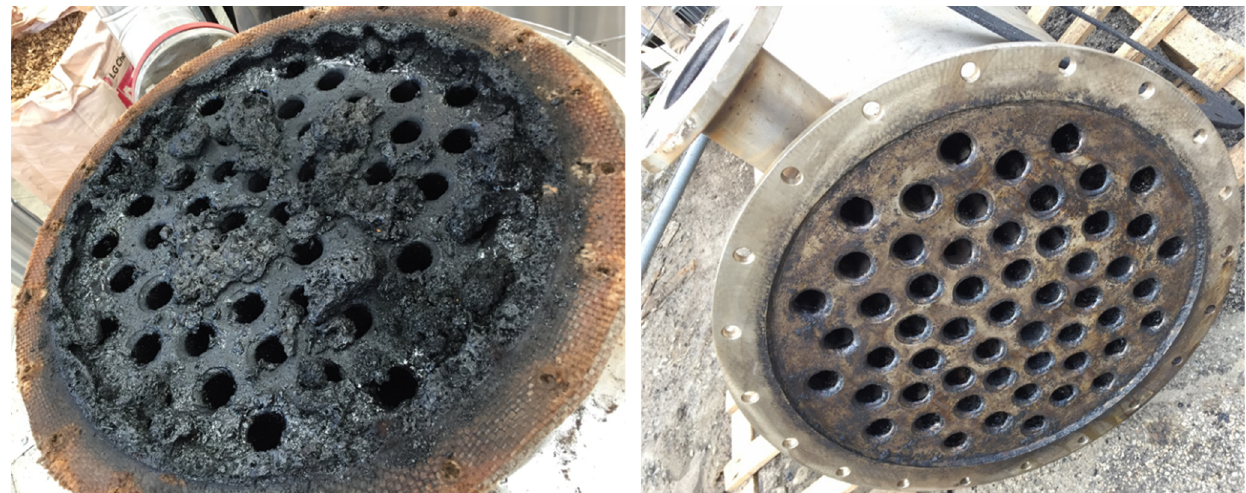
Figure 11. Upper tube plate before ( left ) and after ( right ) mechanical